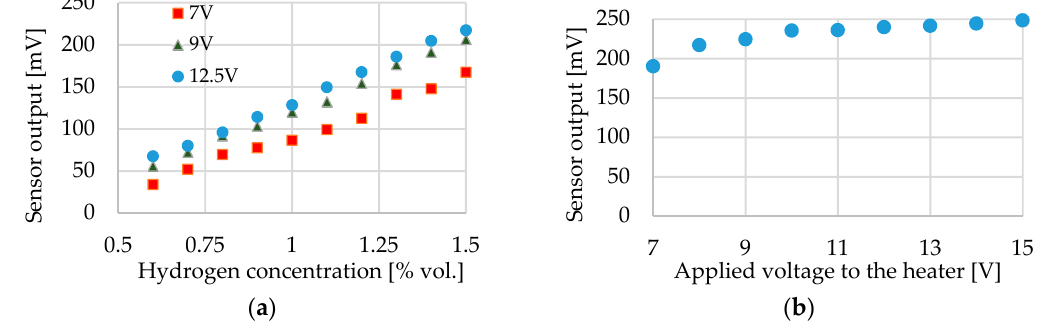
Figure 10. ( a ) Linear characteristics of the sensor with hydrogen concentration for different supply voltage ( b ) sensor output at 1.5% hydrogen concentration for different supply voltages; output saturates after 11 V.